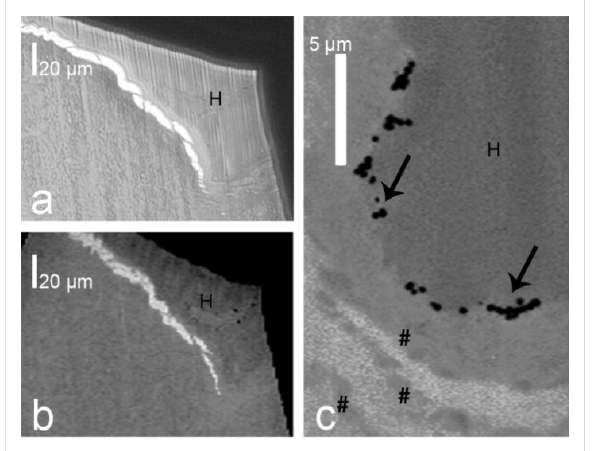
Figure 7: Light microscopy image (a) and scanning transmission X-ray microscopy (STXM) image (b) of a hair follicle opening with a central hair (H) at 270 eV of a 350 nm ultramicrotome section of human facial skin incubated with silica particles (161 ± 13 nm) with a 42 ± 3 nm gold core. Higher magnification of the STXM image visualized single parti- cles (arrows) in an infundibulum on the surface and between corneo- cytes (pound sign) of the stratum corneum